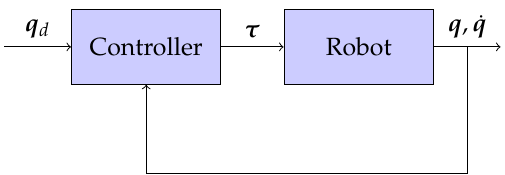
Figure 5. Standard motion control scheme.